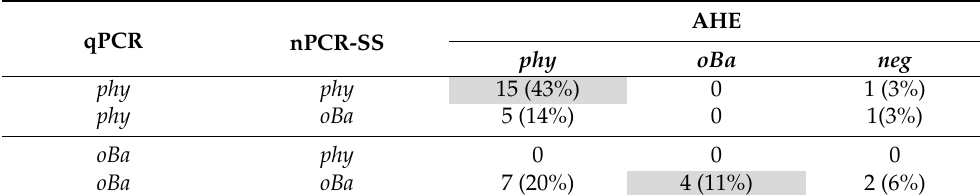
Table 2. Contingency table of positive phytoplasma detection based on comparison of two traditional Polymerase Chain Reaction (PCR) methods, quantitative PCR (qPCR) and nested PCR followed by Sanger sequencing (nPCR-SS), and the new next generation sequencing method, Anchored Hybrid Enrichment (AHE). The outcome of the analyses is depicted by the following acronyms: phy, positive detection for phytoplasma; oBa, positive detection of another Bacteria; neg , negative detection. In gray results that are fully congruent among